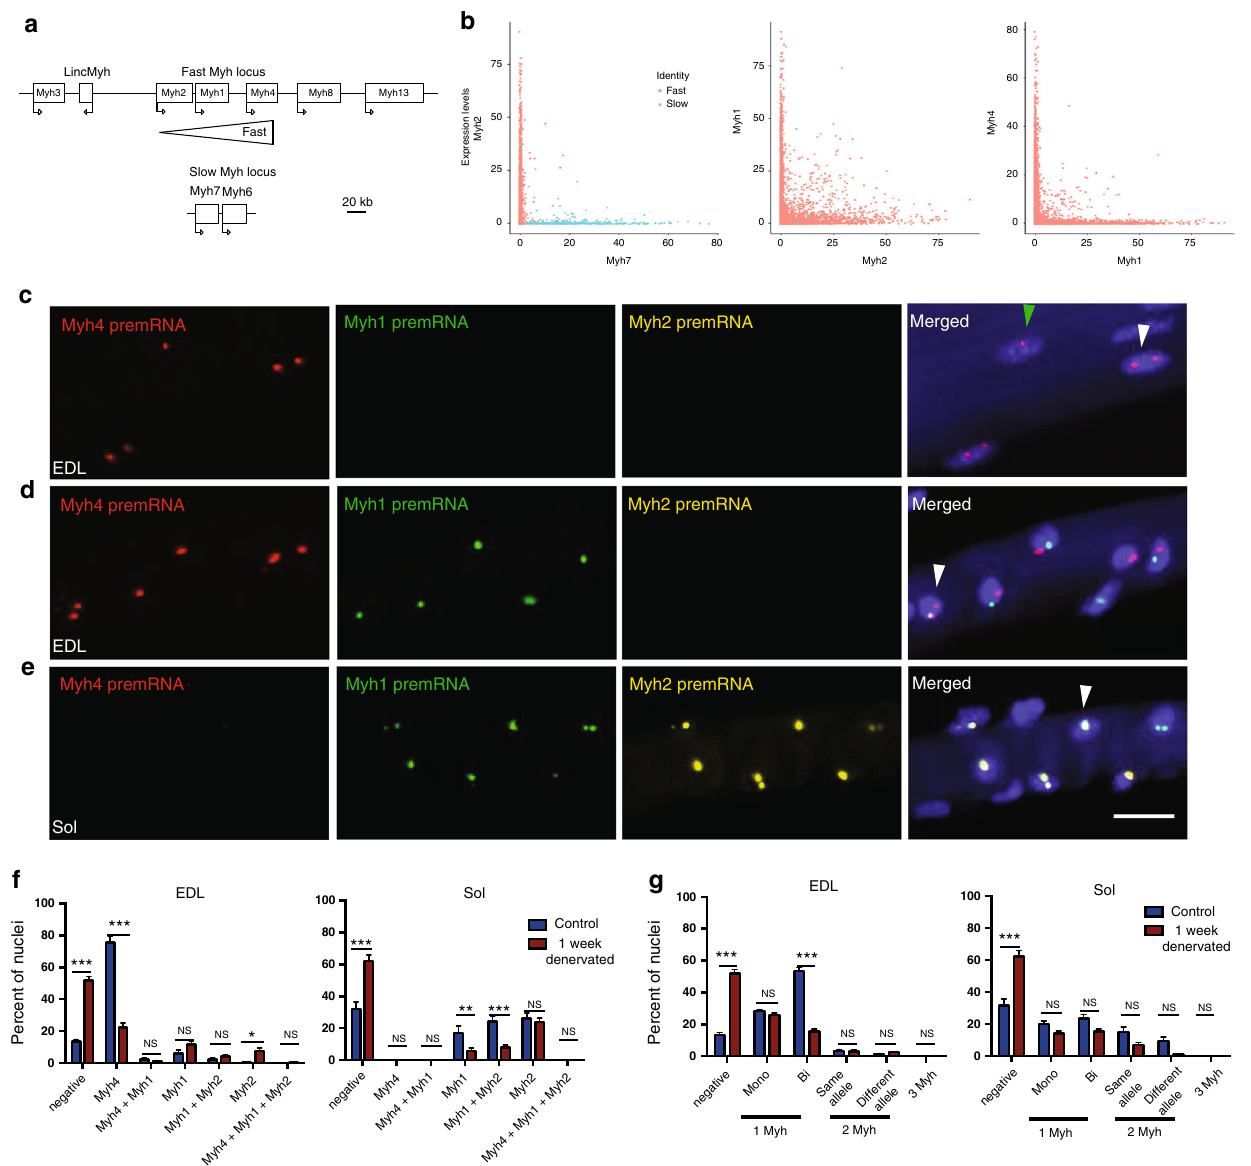
Fig. 4 The majority of myonuclei express only one isoform of Myh . a Diagram of the mouse Myh fast and slow loci. b Analysis of Myh isoforms expression in myonuclei from snRNA-seq data. Each dot corresponds to a myonucleus and the x - and y -axis corresponds to the indicated Myh expression level. c RNAscope experiments on isolated fi bers from EDL to visualize fast Myh4 (red), Myh1 (green) and Myh2 (yellow) pre-mRNAs. Myh pre-mRNA can be detected as two transcribed alleles (white arrowhead) or as a single allele (green arrowhead). d Same as c showing nuclei expressing at the same time different isoforms of Myh from each Myh allele and nuclei co-expressing (arrowhead) at the same time two isoforms of Myh from the same allele. e Same as c in soleus showing nuclei co-expressing at the same time Myh1 and Myh2 pre-mRNAs from each allele (arrowhead). f Percentage of nuclei expressing f Myh pre-mRNAs, in control and 1 week after denervation, in fast myo fi bers from EDL and soleus. g Percentage of nuclei expressing one, two, and three isoforms of pre-mRNAs of Myh in control or 1-week denervated EDL and soleus. Percentage of mono- and bi-allelic expression is also indicated. For c – e scale bar: 20 μ m. For f and g , n = 3 and 20 fi bers per animal. Numerical data are presented as mean ± s.e.m. * P < 0.05, ** P < 0.01, *** P < 0.001. Source data for ( f , g ) are provided in the Source Data fi